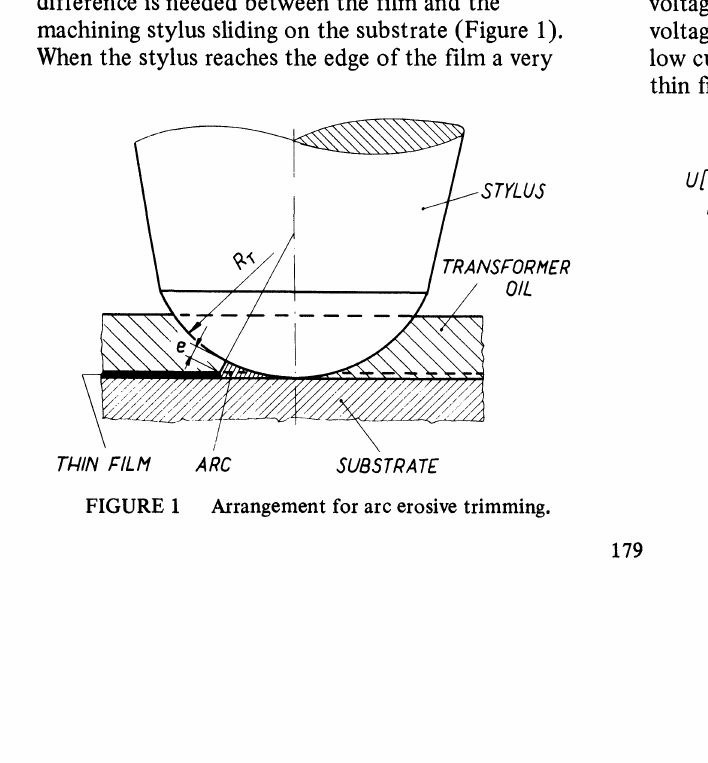
The characteristics of erosive